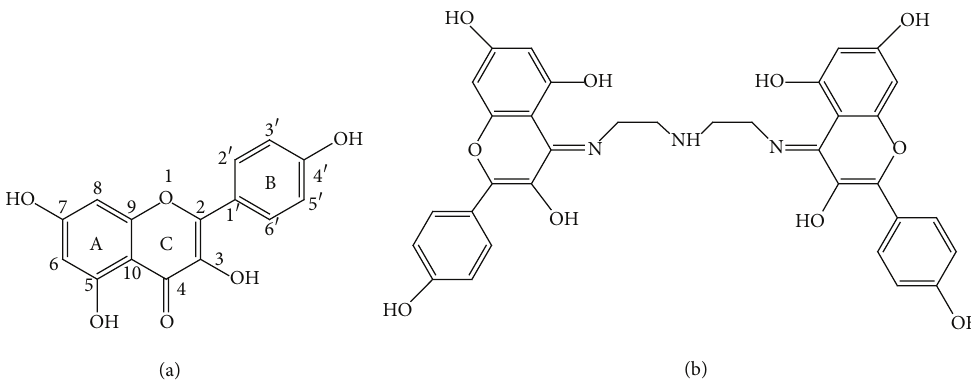
Scheme 1: Kaempferol (a) and Schiff base ligand L derived from kaempferol and diethylenetriamine